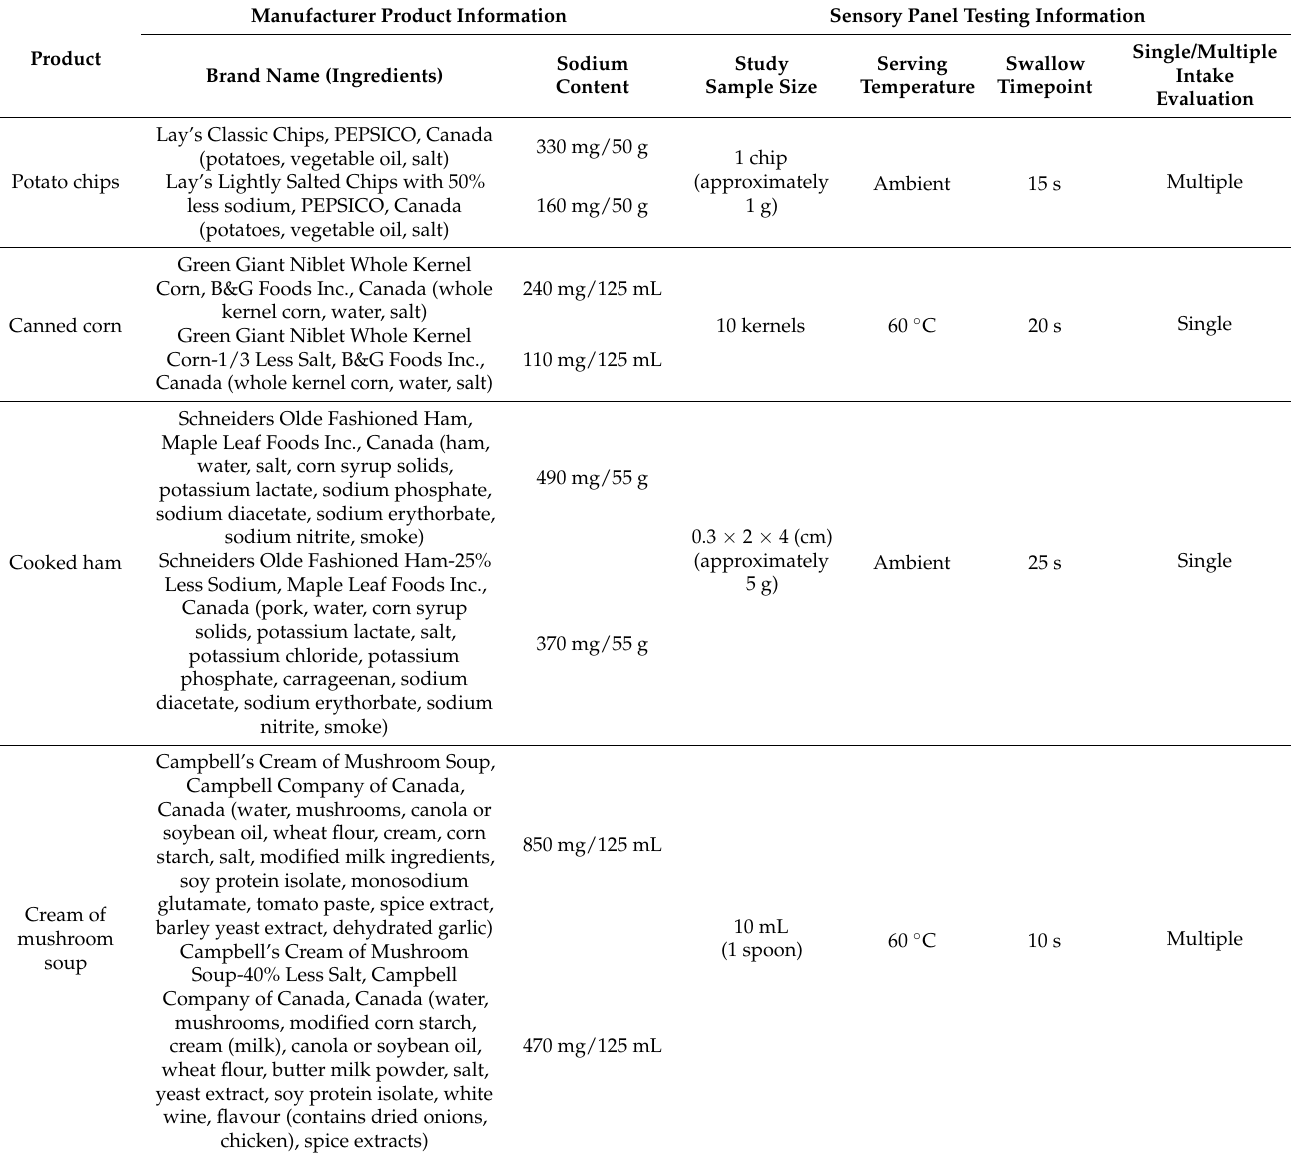
Table 1. Product and sensory panel testing information for evaluation of potato chips, canned corn, cooked ham and cream of mushroom